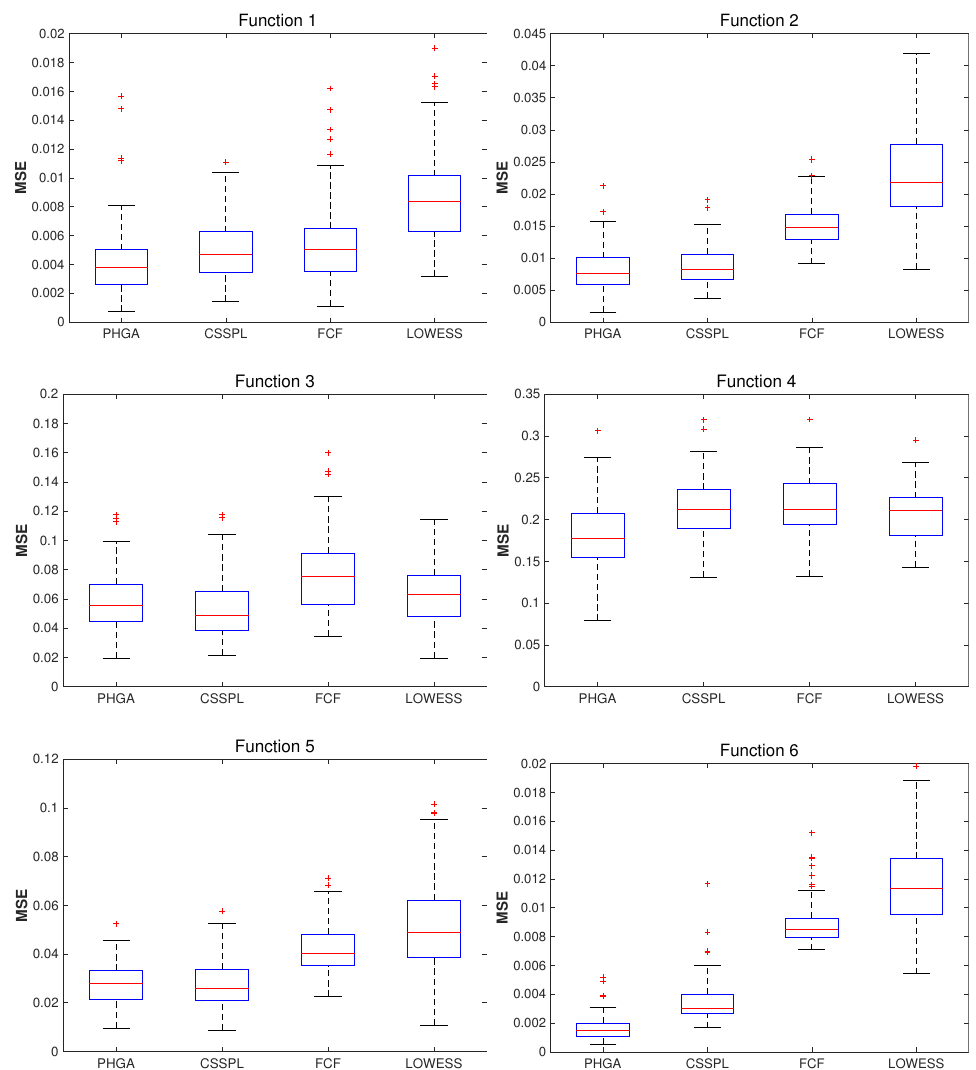
Figure 5. Boxplots of MSE computed for each algorithm per function, using 100 test sets, 100 scattered points(x,y) and SNR =